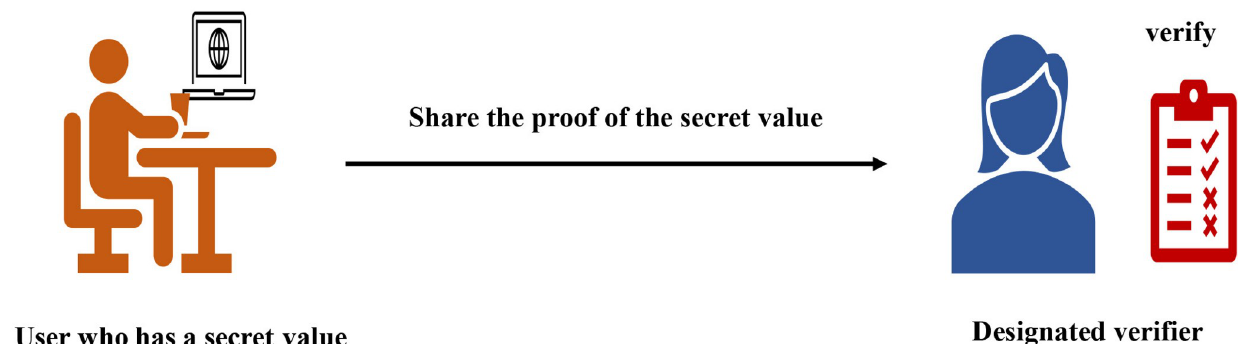
Fig 1. The designated-verifier scheme architecture.